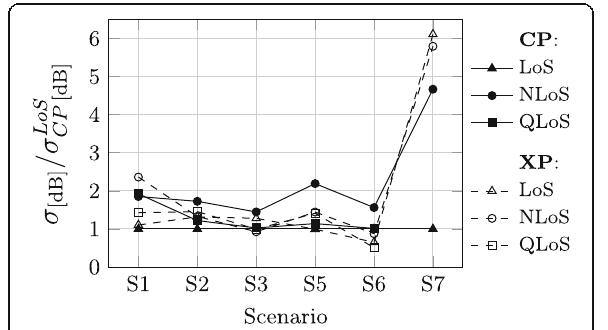
Fig. 7 Relative R 2 values compared to the approach where xLoS are considered separately and no constraint is imposed on n